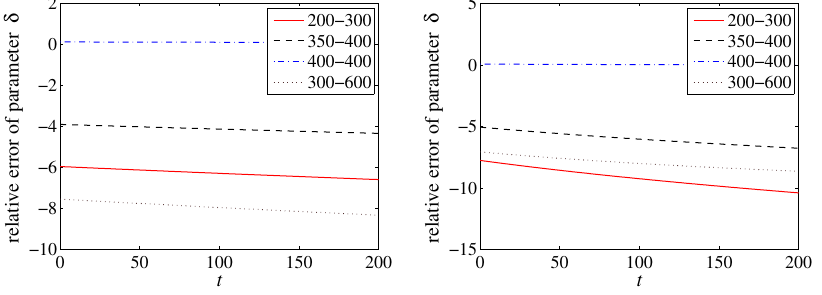
Figure 7. Relative error for the parameter δ . The base of comparison is our approximate solution; left - for h = 1, right - for h = 0 .